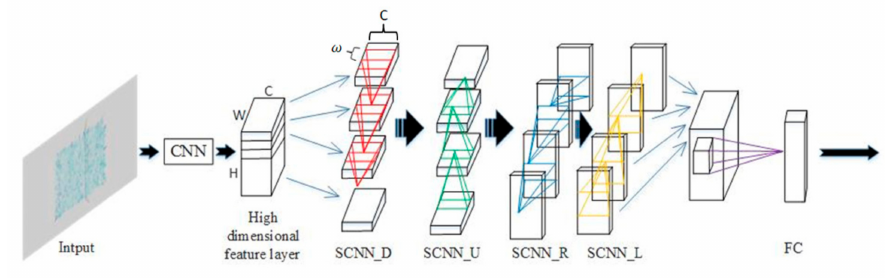
Figure 6. Schematic diagram of spatial direction convolution; ω =